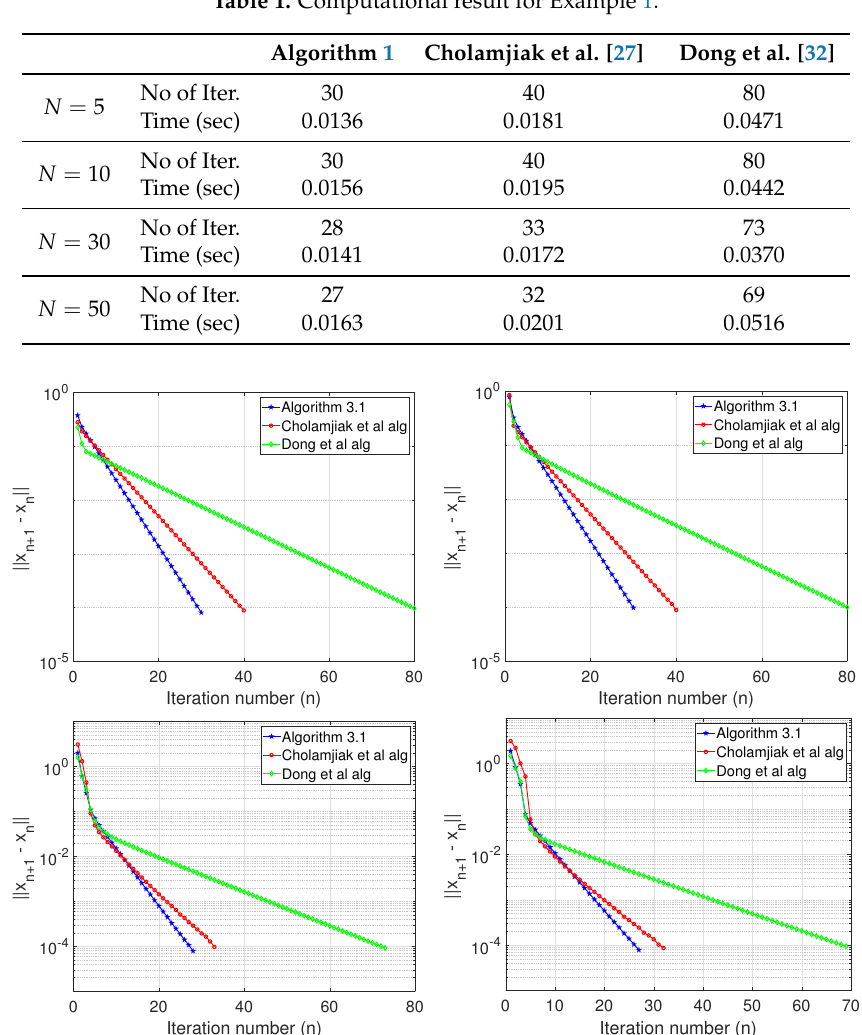
Table 1. Computational result for Example 1.